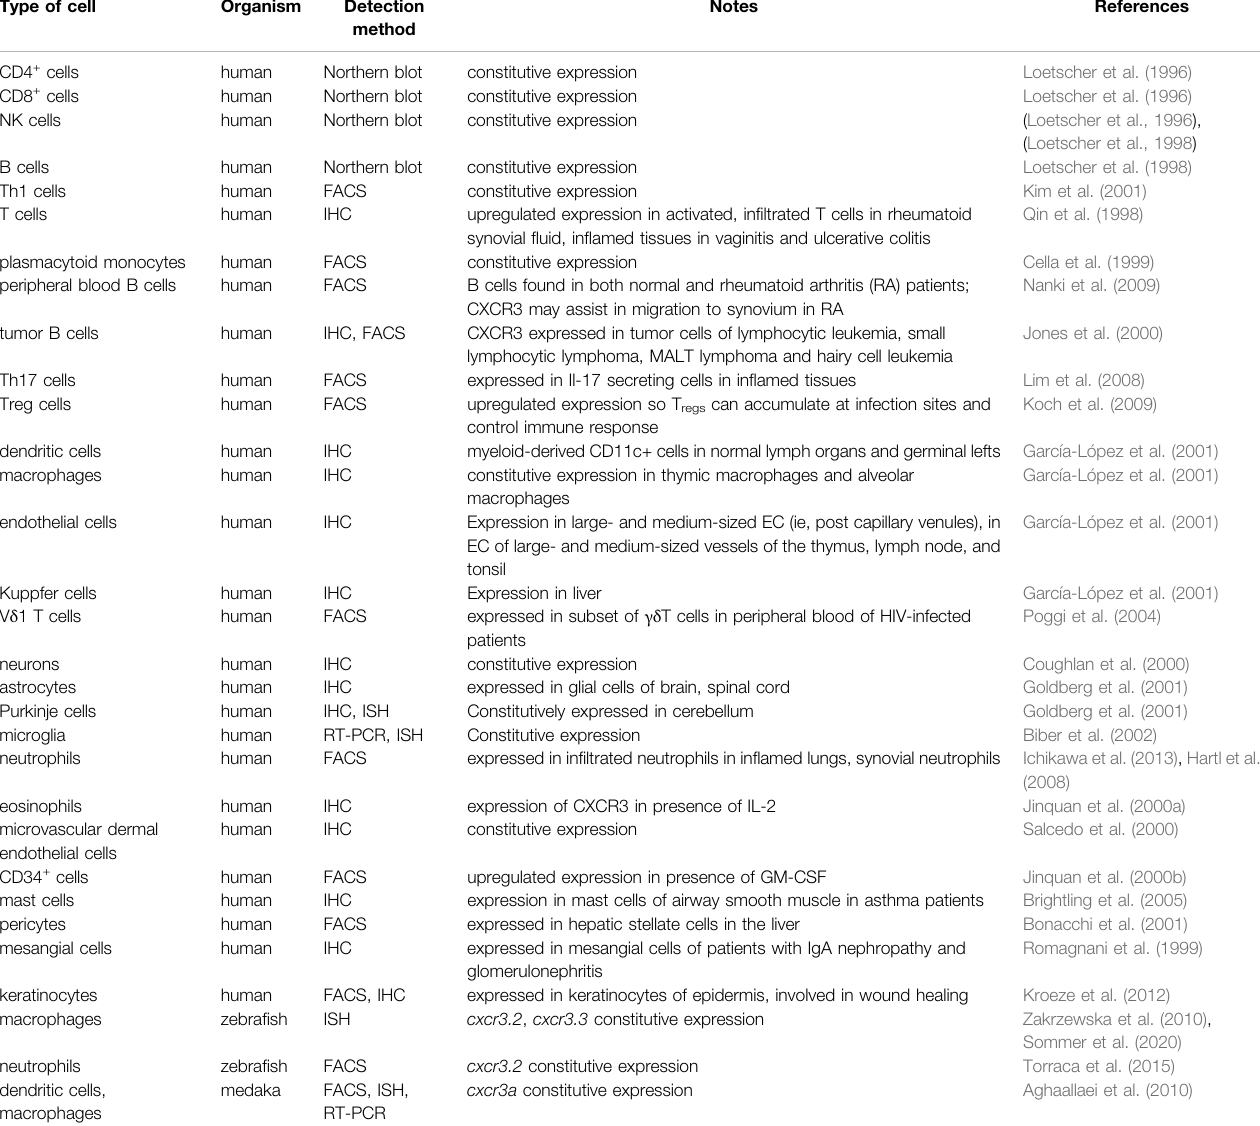
TABLE 2 | Various cell types express CXCR3. IHC, immunohistochemistry; ISH, in situ hybridization; FACS, fl uorescence-activated cell sorting. Type of